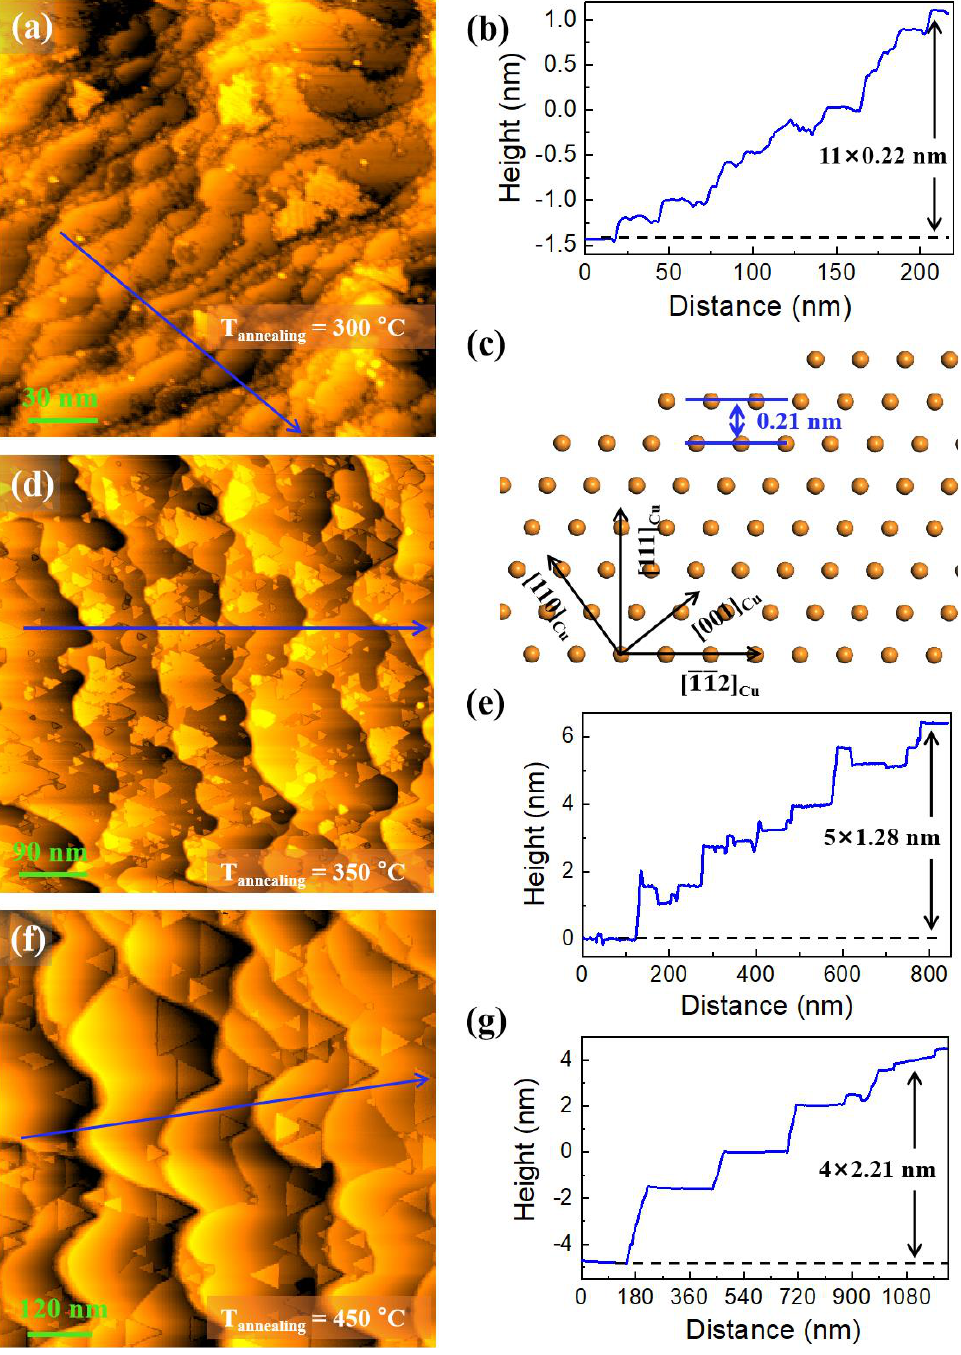
Figure 1. Morphology evolution from 300 °C to 450 °C. ( a ) STM image from the sample after Process Ⅰ annealing treatment, the blue arrow indicates the position where height profile was extracted. ( b ) height profile along the blue arrow in ( a ); ( c ) side view of the atomic model along the [1 1̅ 0]Cu azi- muth; ( d , f ) the STM images from the sample after Process Ⅱ and Ⅲ annealing treatments, respec- tively, the blue arrows indicate the positions where height profiles were extracted; ( e , g ) height pro- files along the blue arrows in ( d , f ), respectively. Here, the scanning bias voltage and current are equal to 1 V and 0.1 nA, respectively.